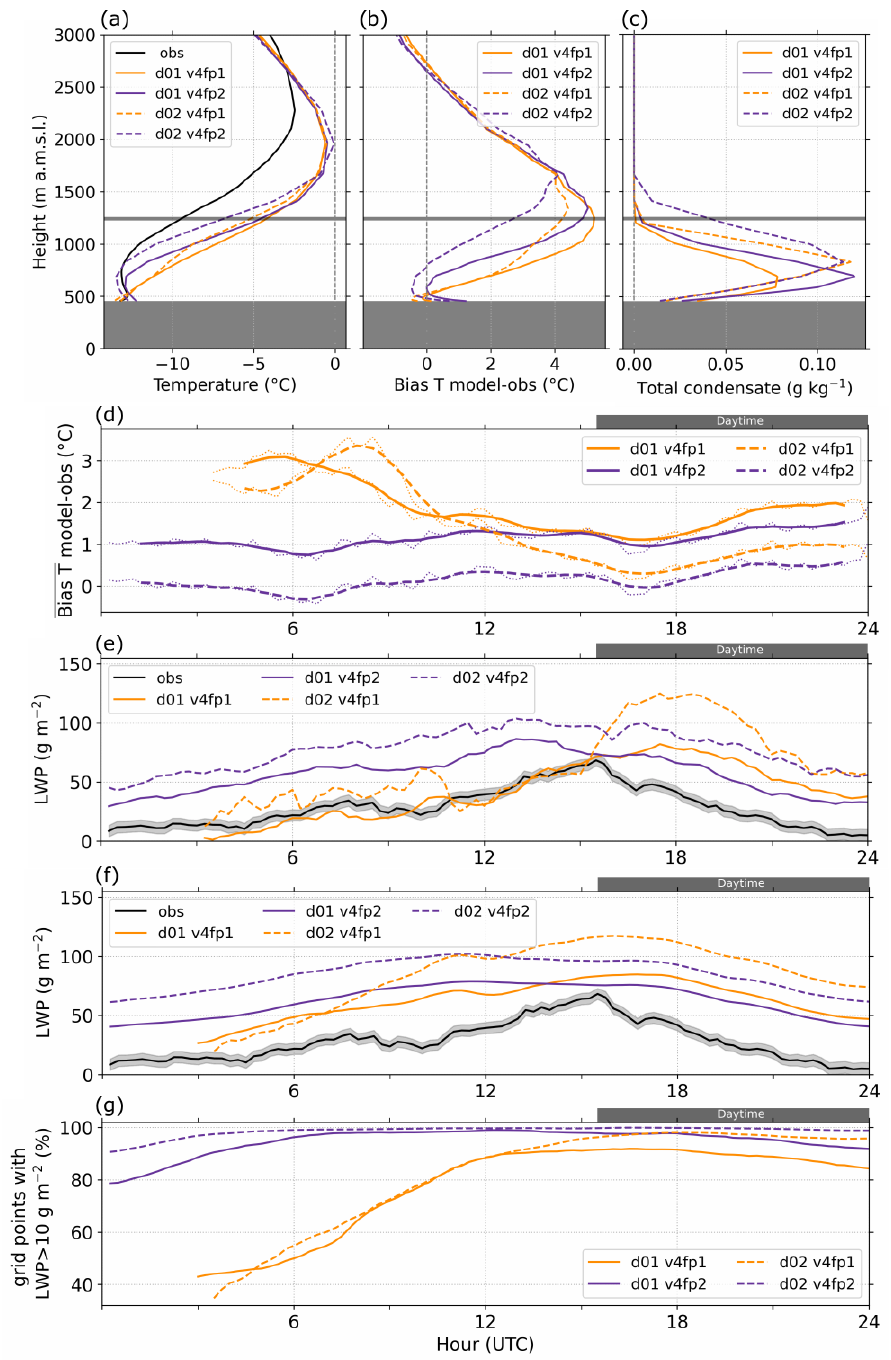
Figure 9. Mean profiles of (a) observed and simulated temperature, (b) temperature bias, and (c) simulated total condensate (cloud liquid water, ice, and snow mixing ratio) at Wasco during the CAP period for v4fp1 and v4fp2. The horizontal gray line indicates the mean ridge height, and dark gray shading indicates the station height. Composite time series of (d) temperature bias averaged up to the mean ridge height and (e) the observed and simulated LWP at Wasco; (f) the observed LWP at Wasco and the simulated mean LWP averaged over all grid points in the Columbia River basin; and (g) the percentage of grid points in the basin with LWP > 10gm − 2 during the CAP period. In panel (d) , dotted lines show the 15min output, and solid and dashed lines are smoothed with a 2h window. Shadings in panels (d) and (e) indicate the 1 σ uncertainty of the LWP from the TROPoe retrievals. In panels (e) and (f) , only grid points with a terrain height of less than 500ma.m.s.l. are